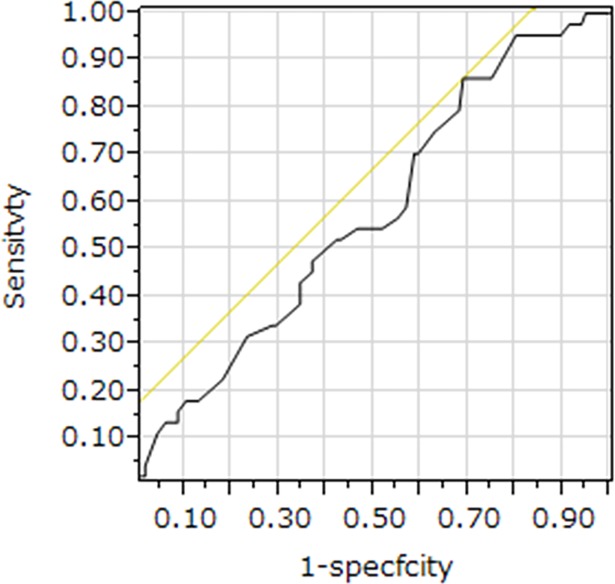
The receiver operating characteristic (ROC) curve for the density of tumor infiltrating lymphocytes (TILs).We treated the five-year relapse-free survival as the state variable and the percentage of tumor infiltrating lymphocytes (TILs) as the test variable. The most appropriate cut-off value for the percentage of TILs to be 42% was shown by the investigation of the cut-off value of percentage of TILs using the receiver operating characteristic (ROC) curve (AUC, 0.5781; sensitivity, 0.8636; specificity, 0.3103).